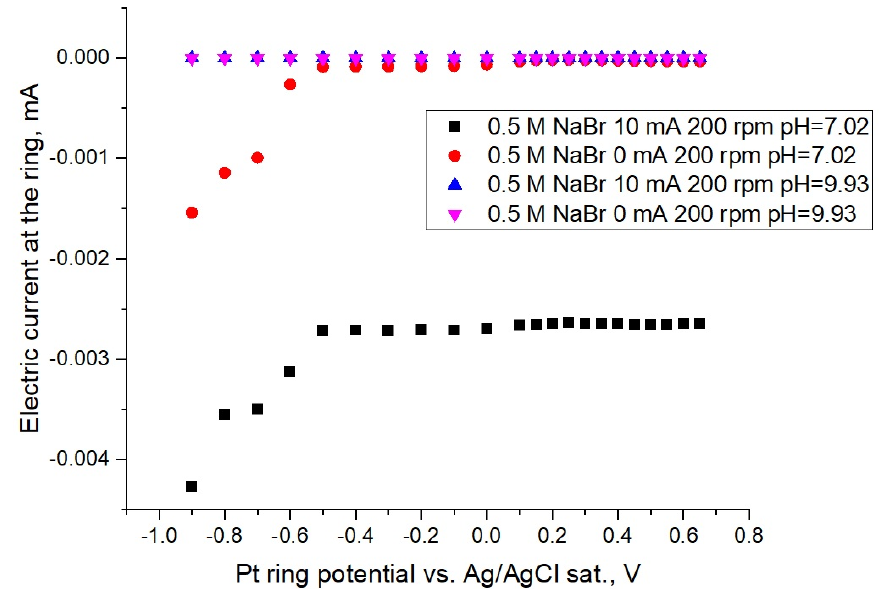
Figure 2. The Pt ring collected current dependencies on the potential for 0.5 M NaBr, at different pH of solutions (black and red points correspond to pH = 7.02, violet and blue points correspond to pH = 9.93) and under stationary conditions while rpm = 200. Simultaneously, data for these solutions in the form of cyclic voltammograms are presented in Figure 1.